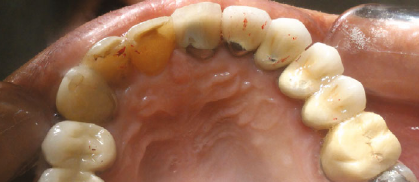
Figure 12: Occlusal view of PFM crowns for upper left lateral, canine, and premolars.